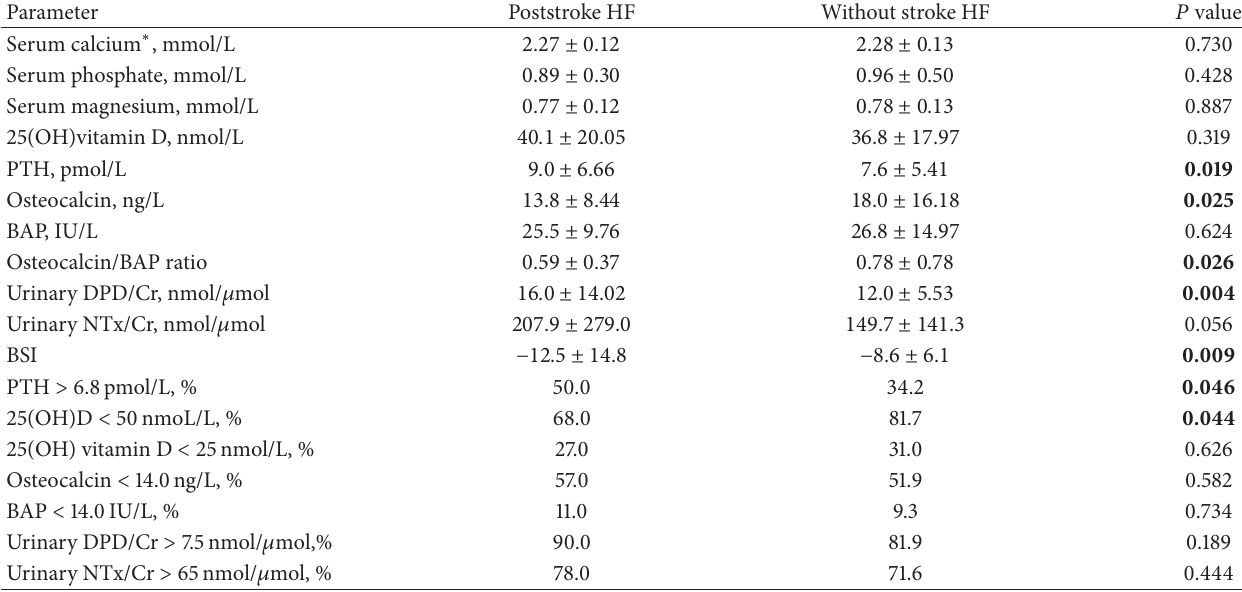
Table 3: Parameters of mineral and bone metabolism in older hip fracture patients with and without history of stroke.